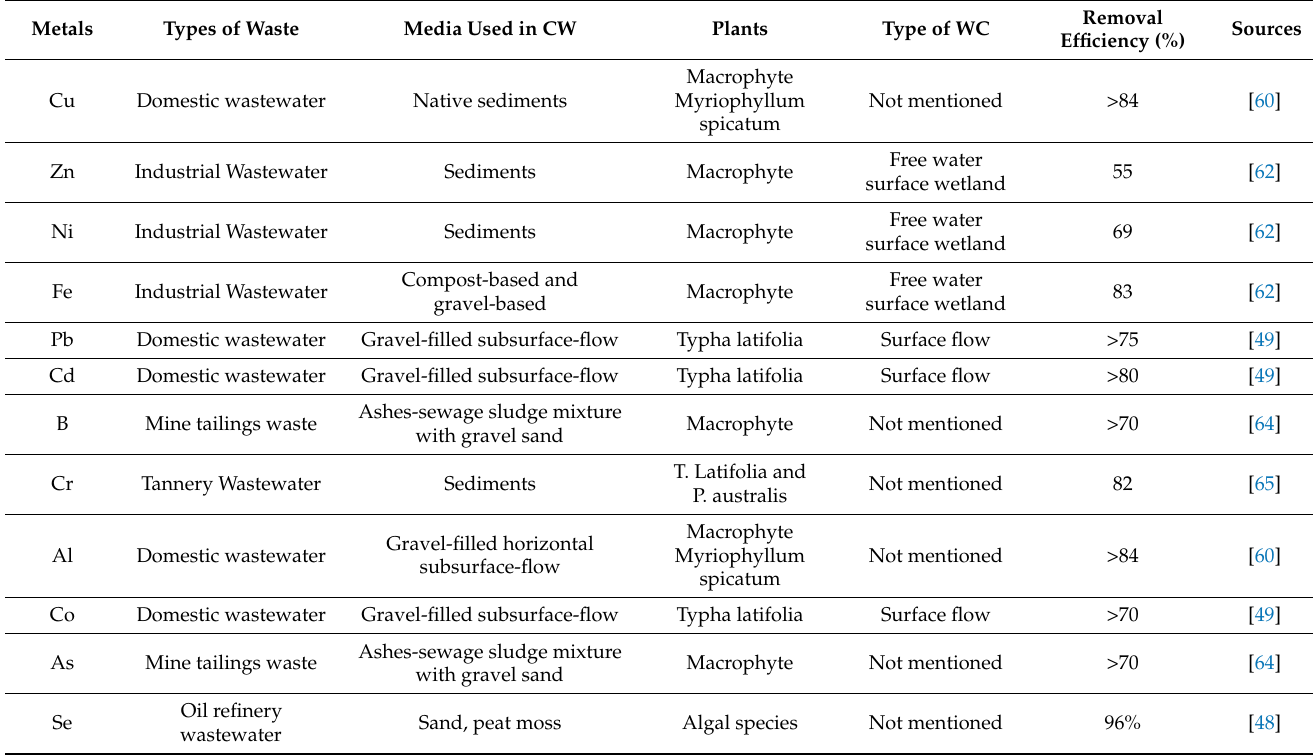
Table 2. Heavy metals removal by CW